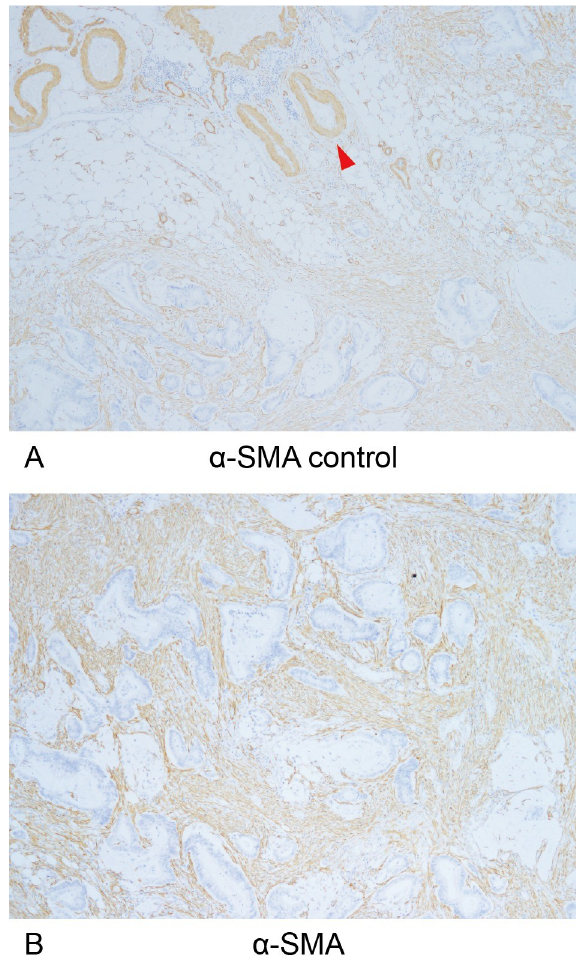
Fig 6. α -SMA-positive cancer-associated fibroblasts and internal positive controls. (A) α -SMA expression in vascular smooth muscle (red arrow) was used as an internal positive control for immunohistochemical staining of anti- α -SMA (x40 HPF). (B) Immunohistochemical detection of α -SMA-positive cancer-associated fibroblasts (x40 HPF).